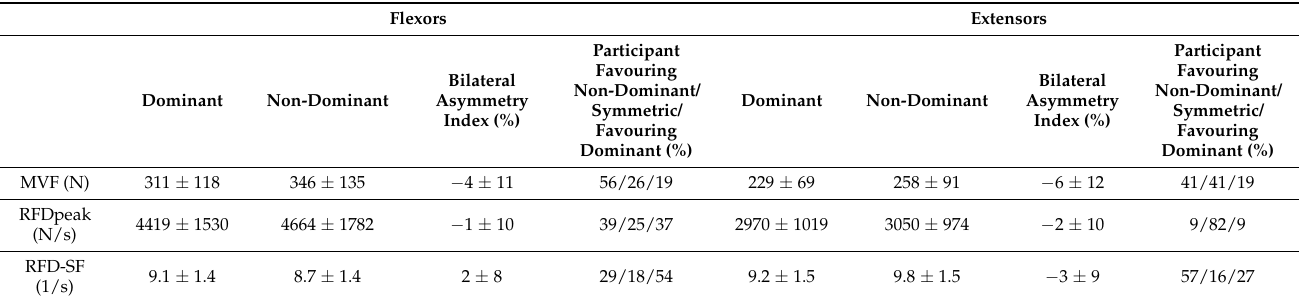
Table 1. The asymmetry index was calculated as ((dominant limb − non-dominant limb)/(dominant limb + non-dominant limb)) × 100 according to previously published studies [34]. Therefore, negative values indicate a favour of non-dominant limb. The percentage of participants favouring non-dominant/symmetric/favouring dominant are computed based on the smallest worthwhile change (SWC).